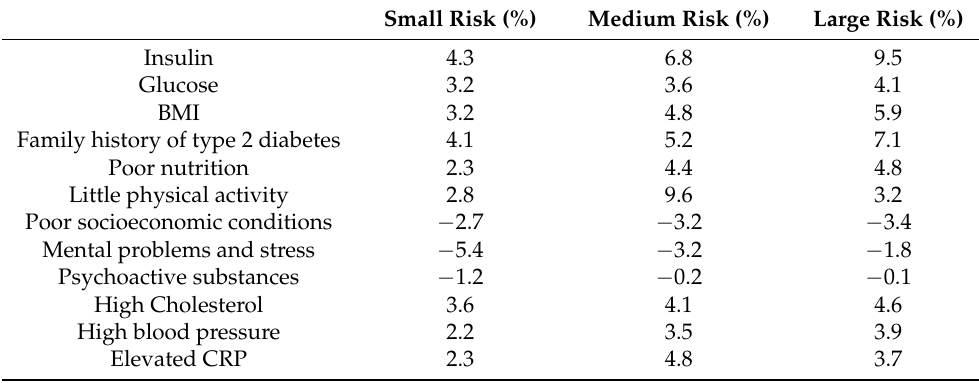
Figure 2. Risk factors for hyperinsulinemia—RBF function. The results obtained using the SVM algorithms show the individual impact of each factor on the overall risk in the groups of low, medium, and high risk for hyperinsulinemia. In the high-risk group, BMI (5.9%) and hereditary factors (7.1%) have the greatest impact, as shown by high cholesterol (4.6%). In the group of respondents with medium risk, the most influential factors are BMI (4.8%) and hereditary factors (5.2%), which are again reflected in high cholesterol (4.1%). In the group of respondents with the lowest risk, the most influential factors are BMI (4.1%) and poor physical activity (2.8%), which again result in elevated cholesterol (3.6%) (Table 6, Figure 3). Table 6. Influence risk factors—SVM